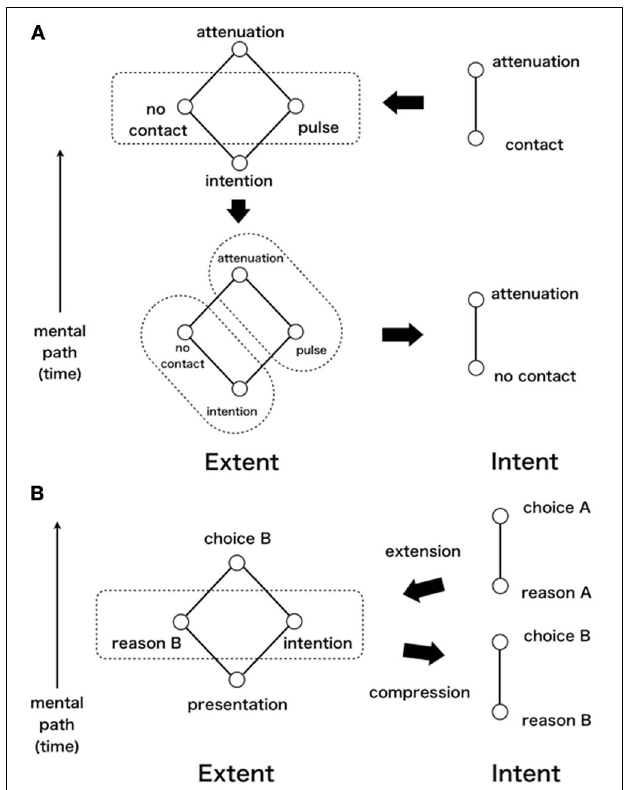
FIGURE 6 | (A) Process of attenuation of sensation. (B) Process of choice blindness.